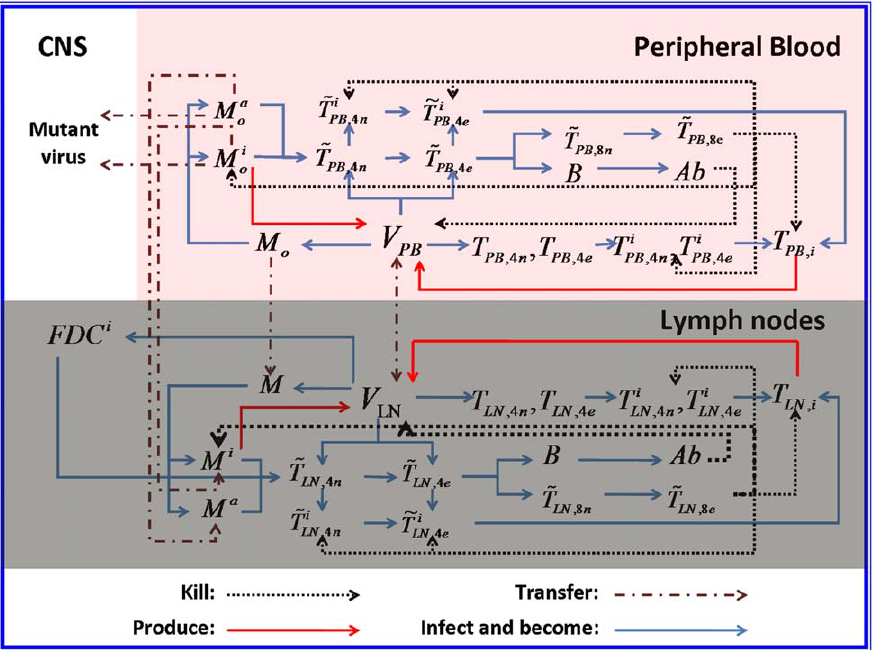
Figure 11. Global model dynamics. Three compartments, peripheral blood (PB), lymph nodes (LNs), and the central nervous system (CNS) are considered in this model. Interactions between different compartments took place mainly between PB and LNs and took the form of the migration of healthy, latently infected, and activated monocytes/macrophages and viral particles. Note that the migration of viral particles is bidirectional, but that of monocytes/macrophages is unidirectional. CNS is only considered with respect to the emergence and replication of mutant HIV-1 that could supplement the PB virus. All the variables shown in the Figure are detailed in Table 6.